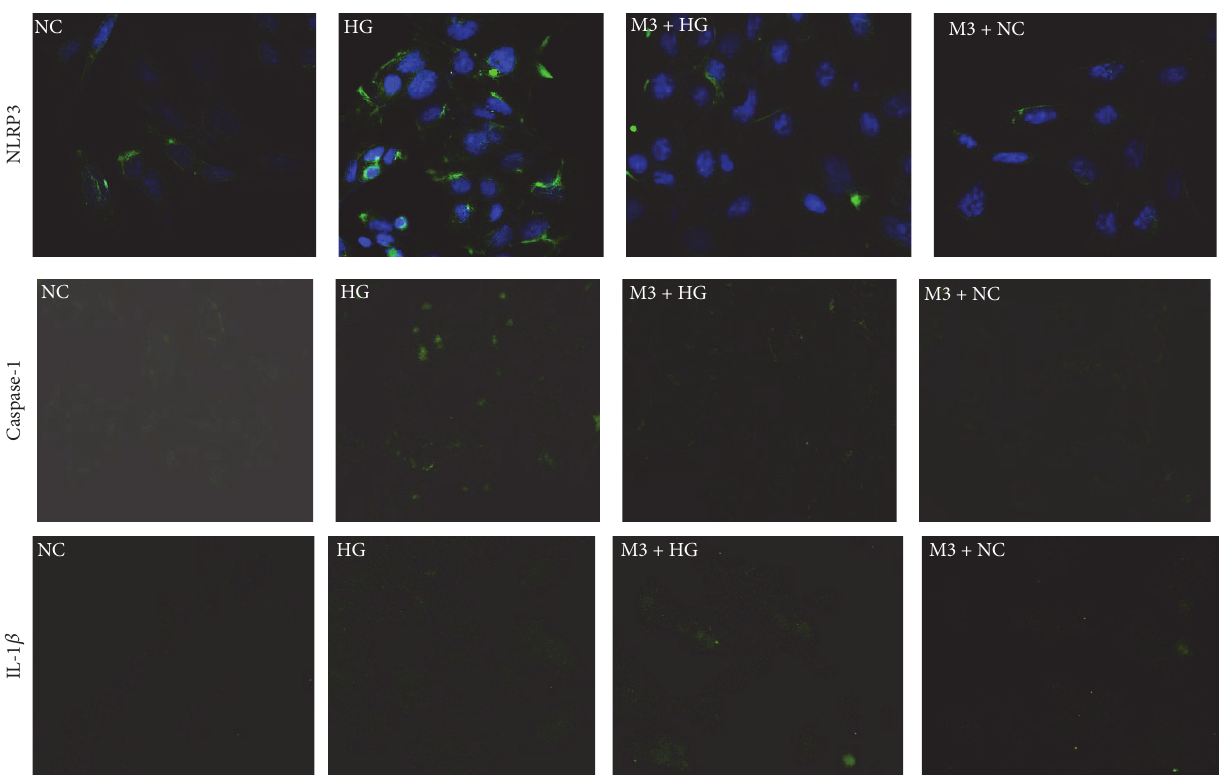
Figure 3: The level of NLRP3, caspase-1, and IL-1 𝛽 in each group detected by immunofluorescence. The expression of NLRP3, caspase-1, and IL-1 𝛽 increased in HG group significantly, but it decreased obviously in M3 + HG group, and there was no difference between NC group and NC + M3